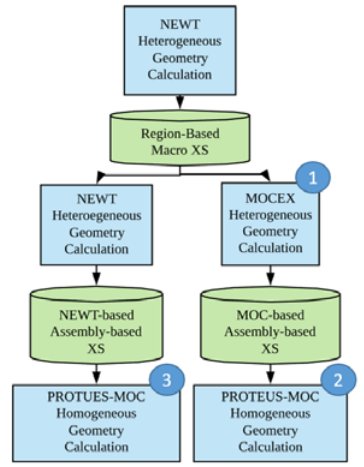
Figure 3. Verification process for MOCEX lattice ability